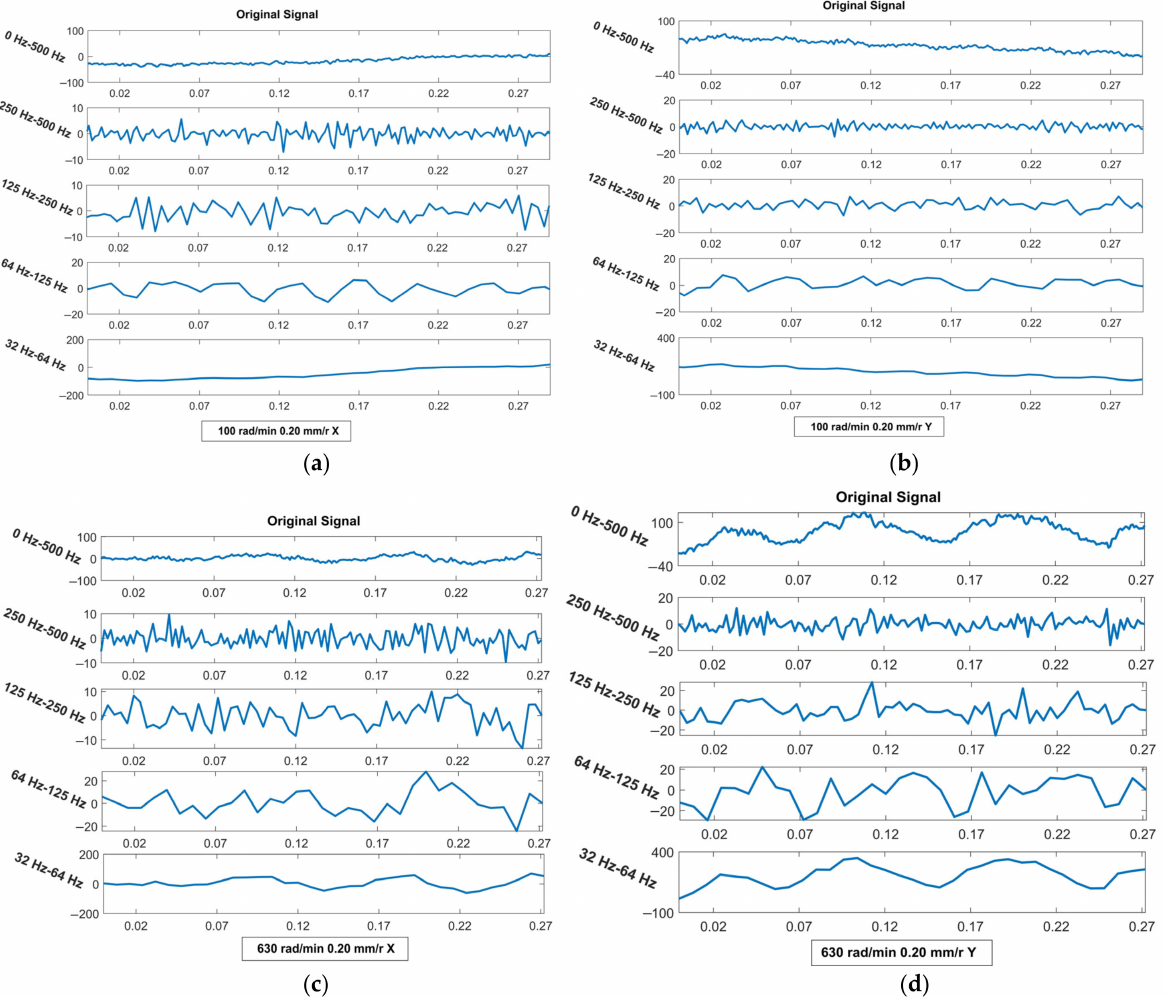
Figure 16. Results of wavelet analysis in the X- and Y-directions when the rotational speed is different and the feed rate is constant (0.20 mm/r). ( a ) Results of wavelet analysis in the X-direction when the rotational speed is 100 rad/min. ( b ) Results of wavelet analysis in the Y-direction when the rotational speed is 100 rad/min. ( c ) Results of wavelet analysis in the X-direction when the rotational speed is 630 rad/min. ( d ) Results of wavelet analysis in the X-direction when the rotational speed is 630